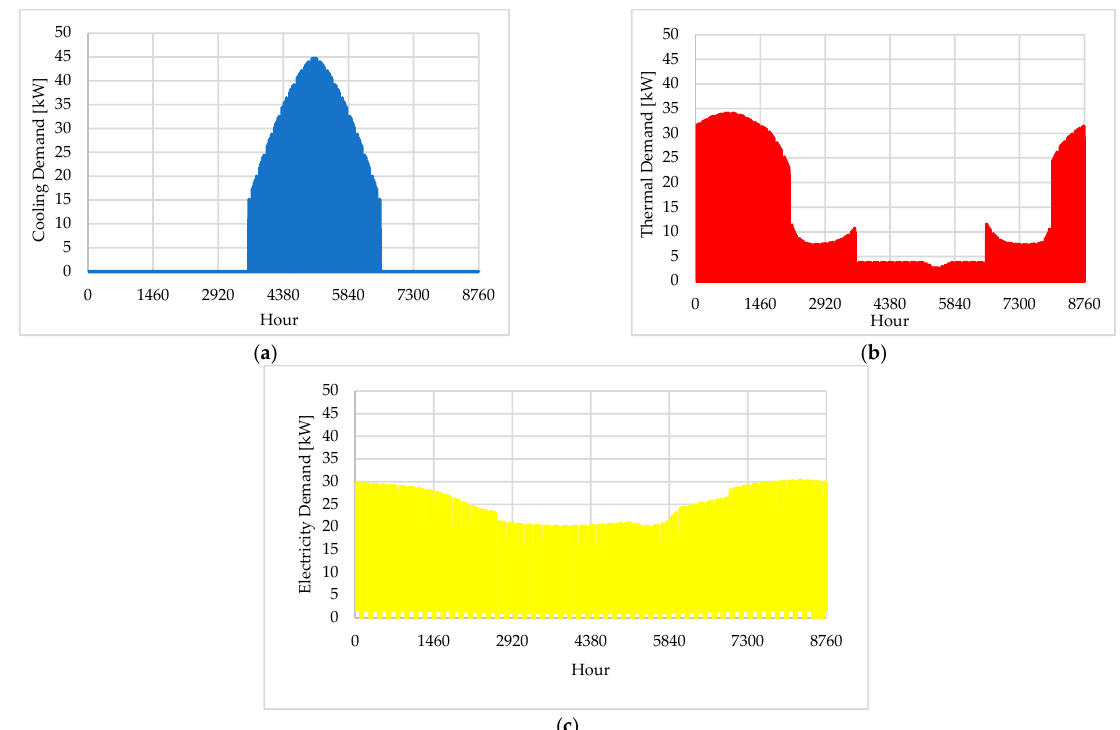
Figure 3. Hourly profiles of the case study: ( a ) cooling, ( b ) thermal and ( c ) electricity demands [40].